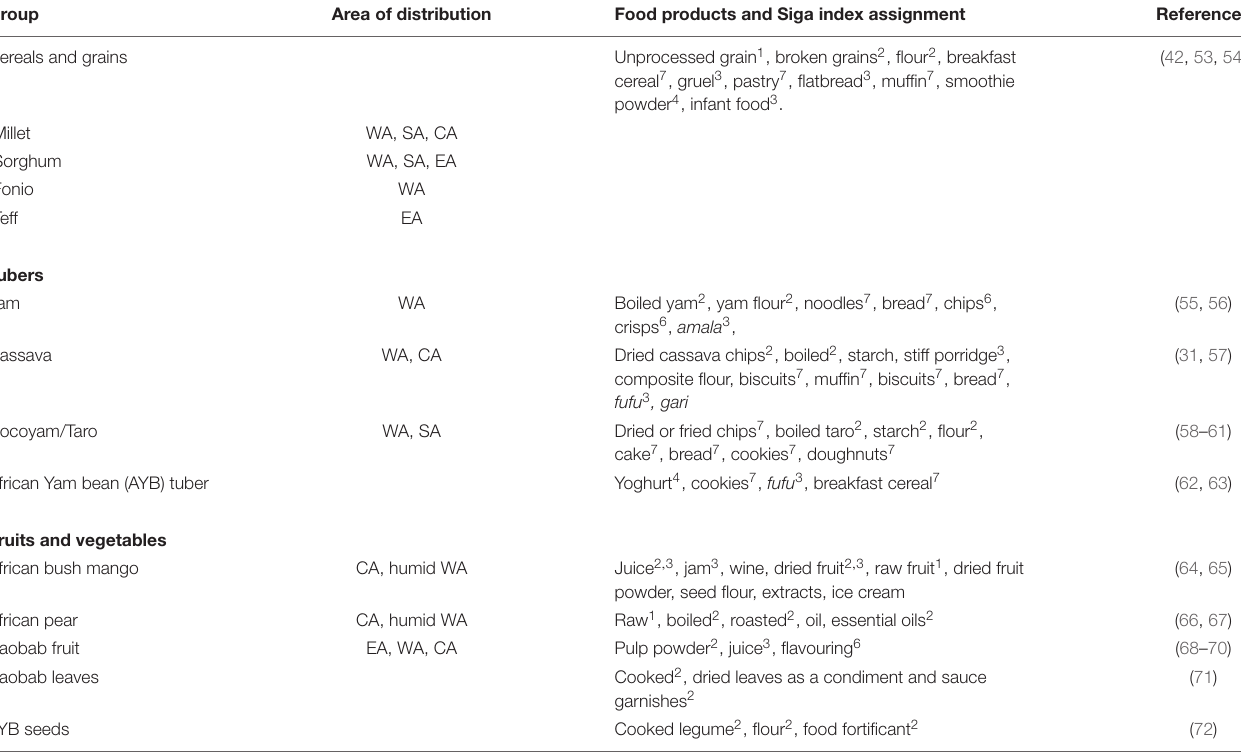
FIGURE 1 | Cereals and grains of Africa. (https://www.google.com/search?q=cereal+grains&sxsrf=AOaemvL2cmQ98ztkUbsjOzKZQi6eK6n95A: 1638149496818&source=lnms&tbm=isch&sa=X&ved=2ahUKEwiryeK2trz0AhUcQUEAHf4CDsYQ_AUoAXoECAEQAw&biw=1366&bih=657&dpr=1. TABLE 3 | Classification of African foods based on their level of processing based on the Siga food processing index.